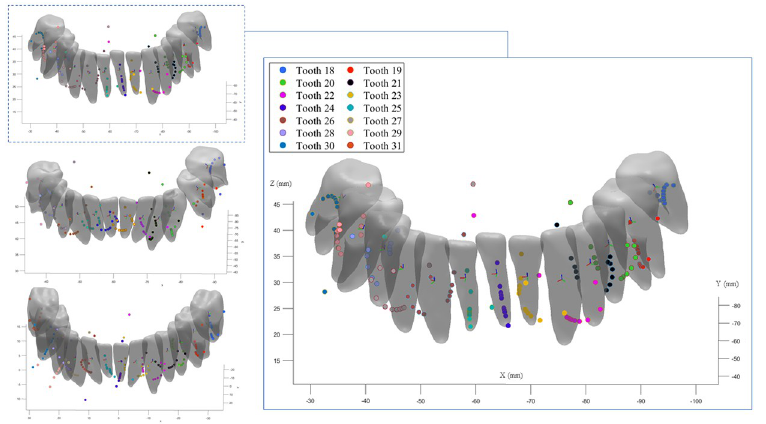
Fig 3. Calculated CRots. Calculated CRots for different couple magnitudes changing from 1N to 13N with 1N intervals shown in 3D space for all teeth with transparent teeth geometries, Left: Results of the three different patients. Right: A closeup view of the results for Patient 1 .